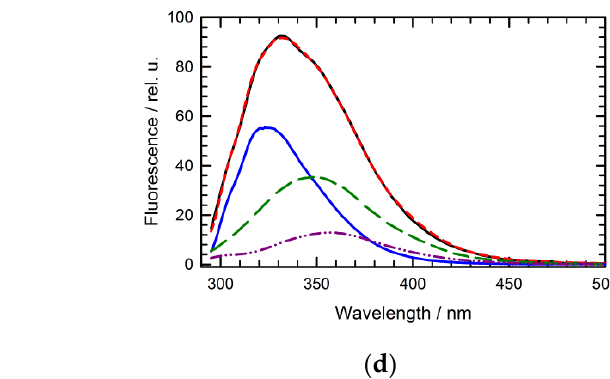
Figure 4. Analysis of the GuHCl-induced unfolding at various Hfq Y55W concentrations: ( a ) A set of selected Y55W fluorescence spectra recorded within the 0 ÷ 5 M GuHCl range (from top to bottom, grayscale) at three protein (monomer) concentrations: 0.8 (top), 6.5 (middle), and 65 µ M (bottom); ( b ) The GuHCl dependence of the spectrum mass center values (Equation (1)) for three Hfq Y55W concentrations. Circles stand for 0.8 µ M, squares for 6.5 µ M, and triangles for 65 µ M. The black symbols represent results of refolding of Hfq Y55W; ( c ) The GuHCl concentration dependences of the state fractions, as derived from the deconvolution of Y55W fluorescence spectra at three protein concentrations: 0.8 (top), 6.5 (middle), and 65 µ M (bottom). Symbols show: hexamer, circles; intermediate, triangles; and unfolded monomer, squares; while solid lines represent simulations based on the three-state unfolding model (3), Equations (3)–(11), and the parameters from Table 2. The vertical dashed line indicates a GuHCl concentration of 1.6 M; ( d ) The result of the best fit of the fluorescence spectrum of Hfq Y55W (6.5 µ M) at 1.98 M GuHCl (black solid line, experiment; red dashed line, the best fit to the three-state model). State contributions: hexamer, blue solid line; intermediate monomer, dark green dashed line; unfolded monomer, dark pink dash-dot-dot line. Best fit fractions: f n = 0.36, f i = 0.47, f u =